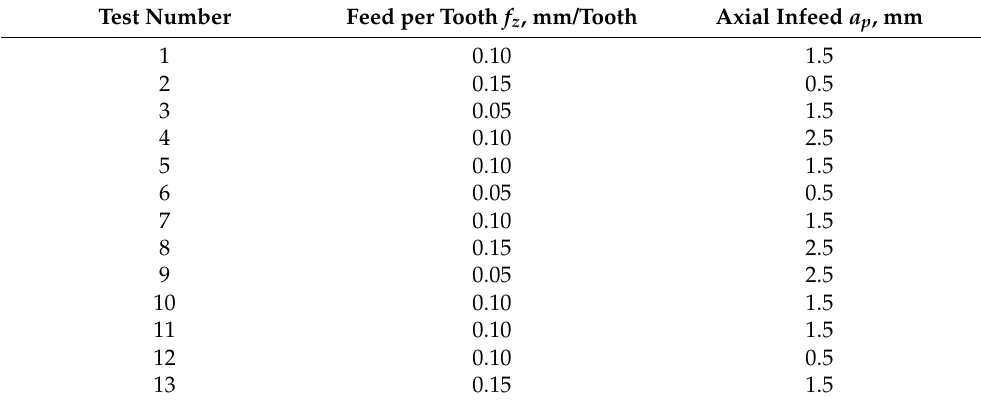
Table 2. Experimental test plan.